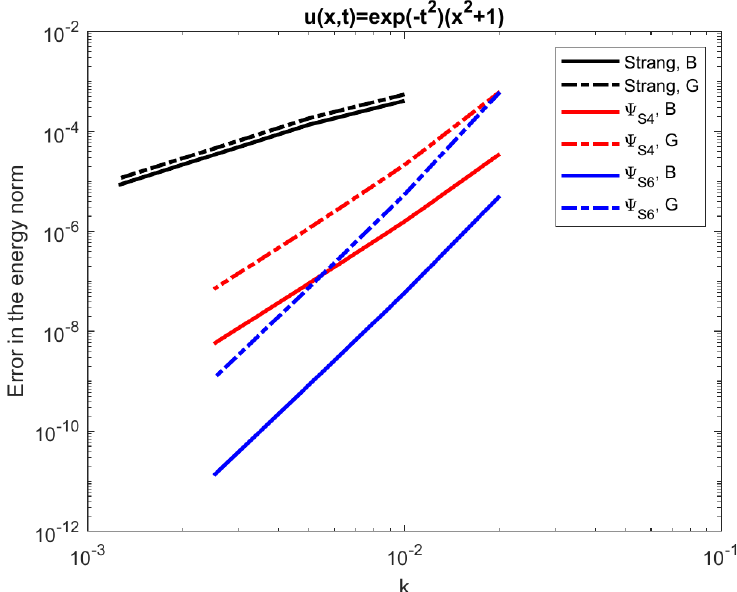
Figure 2. Error in logarithmic scale of energy norm for Test 2, for several options of symmetric- splitting methods, with N = 100 for final time T = 1 and